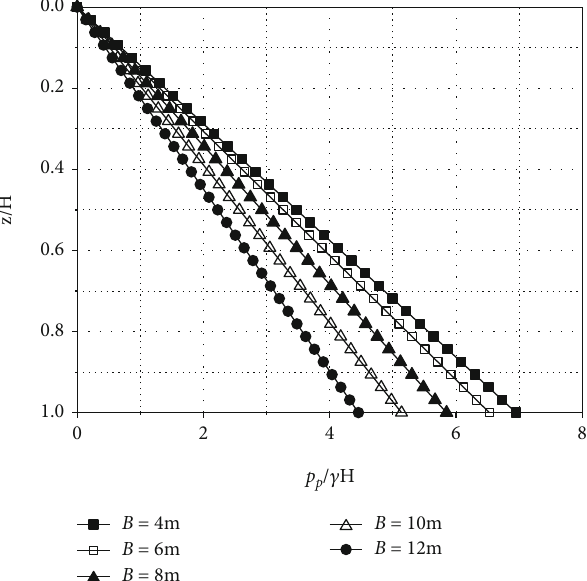
/ γ H versus z / H for the di ff erent back fi ll widths B Figure 13: p p